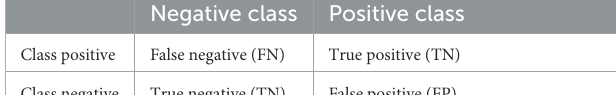
TABLE 10 Performance of the DNN model relative to the different attack types and benign in terms of DR, accuracy, and training time on the UNSW-NB15